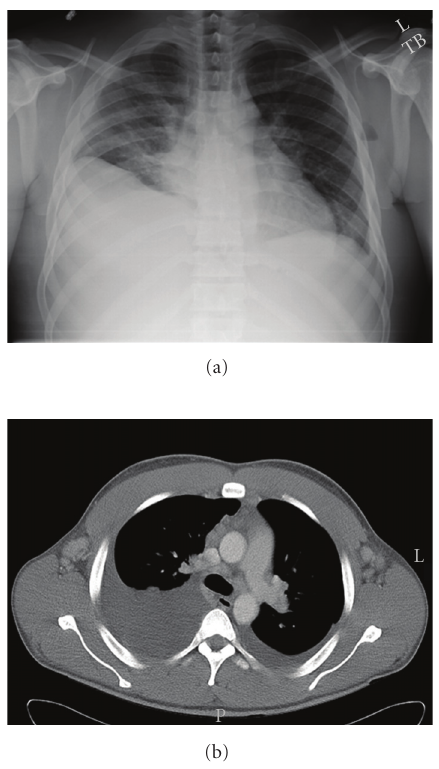
Figure 1: Chest radiography and CT scan of the chest showing bilateral pleural e ff usions.